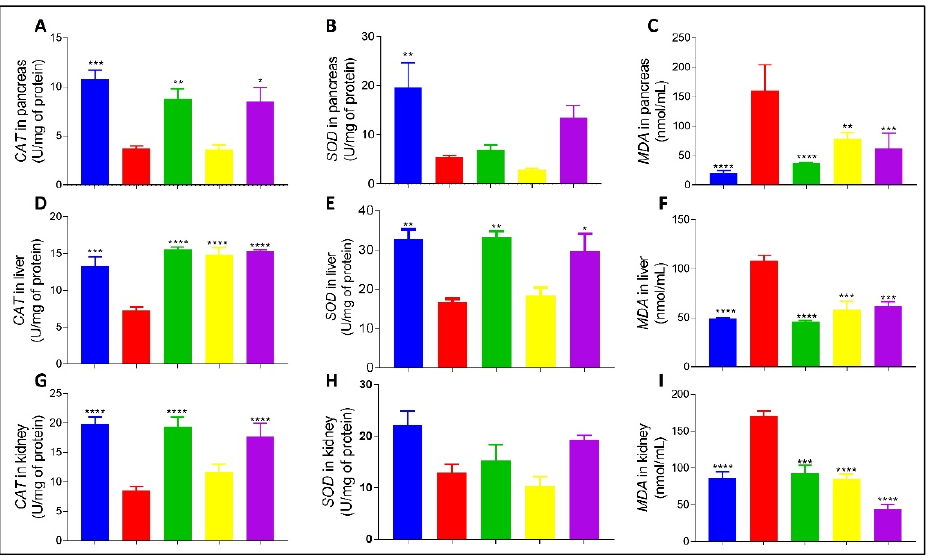
Figure 6 . Effect of BFPP on oxidative stress markers. Normoglycemic (blue), vehicle (red), metformin 250 mg/kg (green), BFFF 50 mg/kg (yellow), BFPP 100 mg/kg (purple); ( A ) pancreas CAT; ( B ) pancreas SOD; ( C ) pancreas MDA levels; ( D ) liver CAT; ( E ) liver SOD; ( F ) liver MDA levels; ( G ) kidney CAT; ( H ) kidney SOD; ( I ) kidney MDA levels. The data are expressed as mean ± SEM, n = 6 animals per group. One-way ANOVA post-test Dunnet; * p ≤ 0.05; ** p ≤ 0.01, *** p < 0.001 and **** p ≤ 0.0001 compared with the vehicle group.